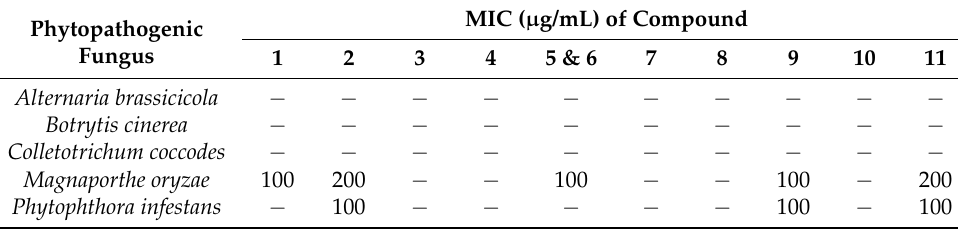
Table 2. In vitro antifungal activity of the compounds isolated from Platycladus orientalis